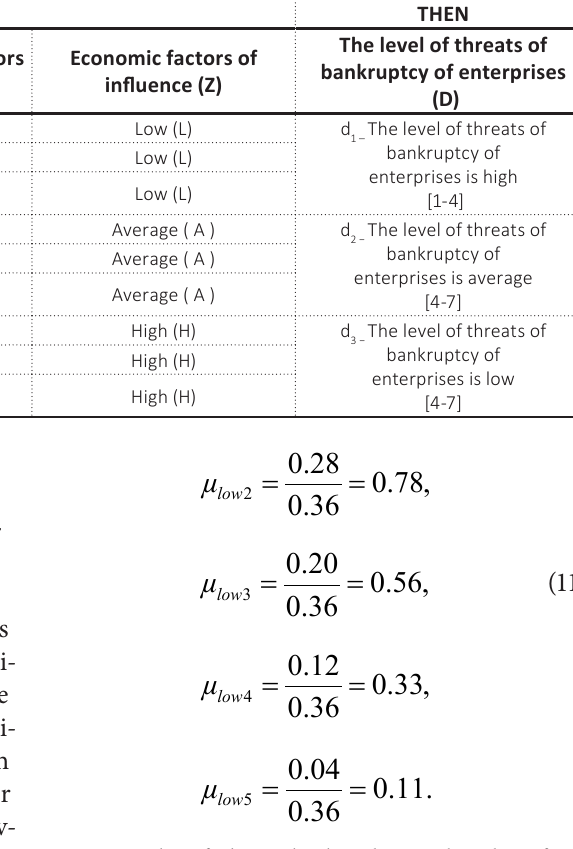
Table 1. Knowledge bases and systems of fuzzy logic equations for dependence (4)